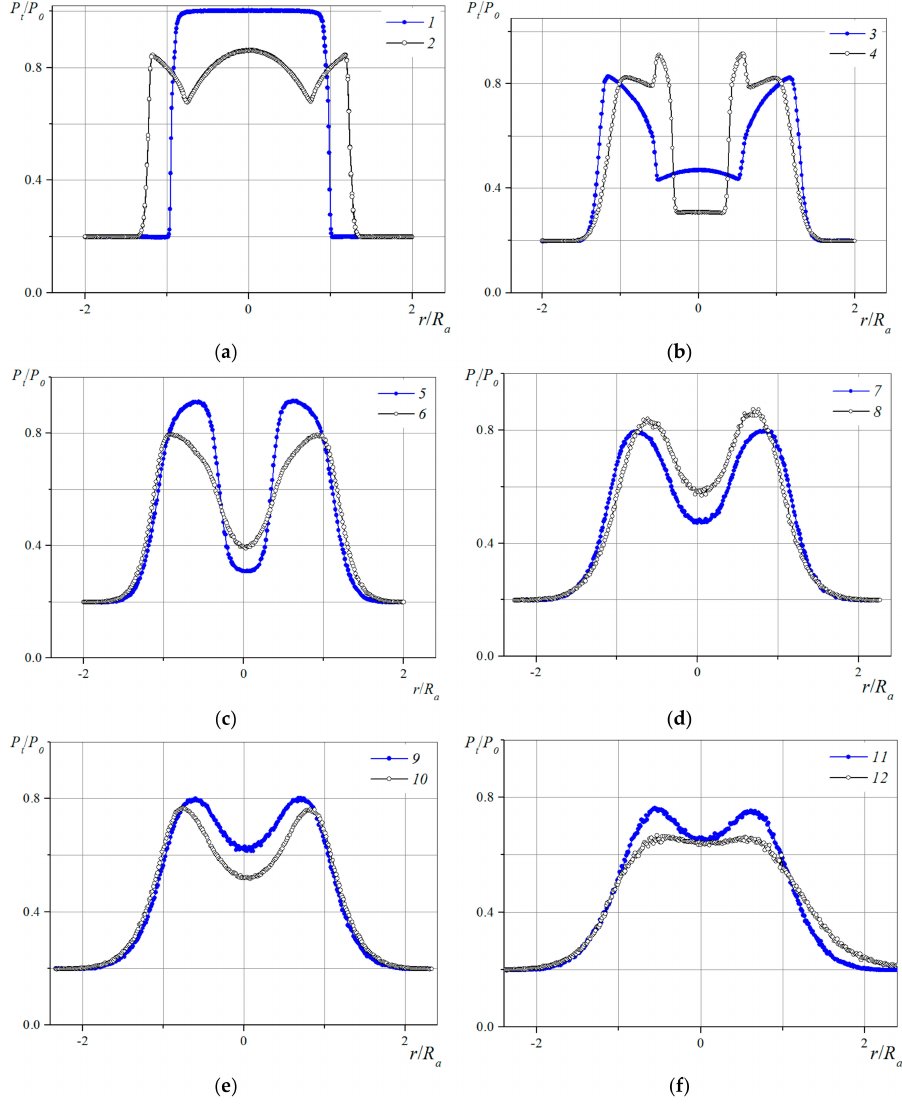
Figure 13. Radial profiles of the relative Pitot pressure measured in several cross-sections of the jet: ( a ) 1, 2—x/R a = 0.03, 1.0, ( b ) 3, 4—x/R a = 2.0, 3.0, ( c ) 5, 6—x/R a = 4.0, 5.0, ( d ) 7, 8—x/R a = 6.0, 7.0, ( e ) 9, 10—x/R a = 8.0, 9.0, ( f ) 11, 12—x/R a = 10.0,